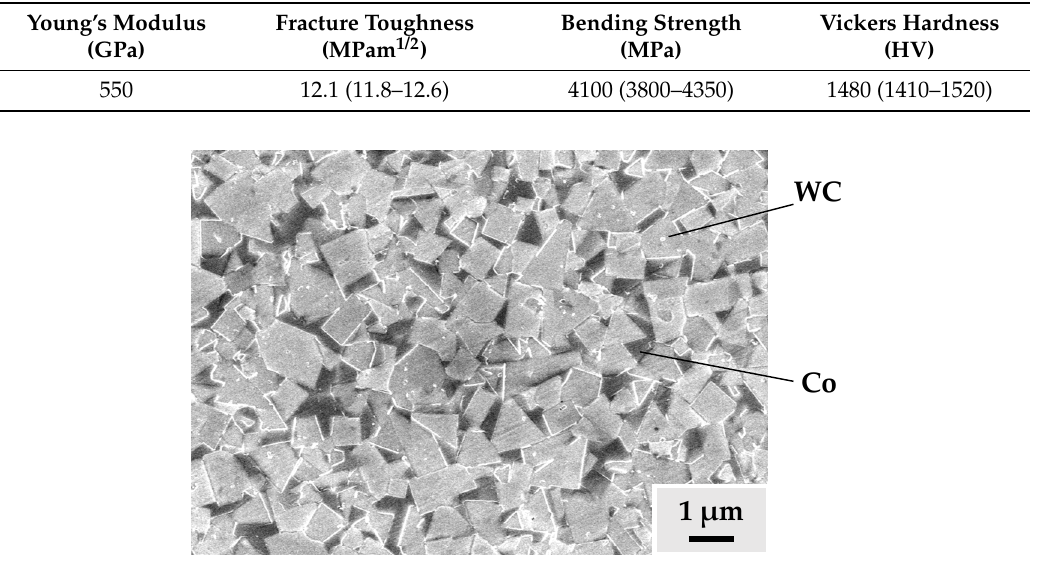
Figure 1. Microstructure of the WC-Co cemented carbide used in the study. The average WC grain size is approximately 0.45 μ m.